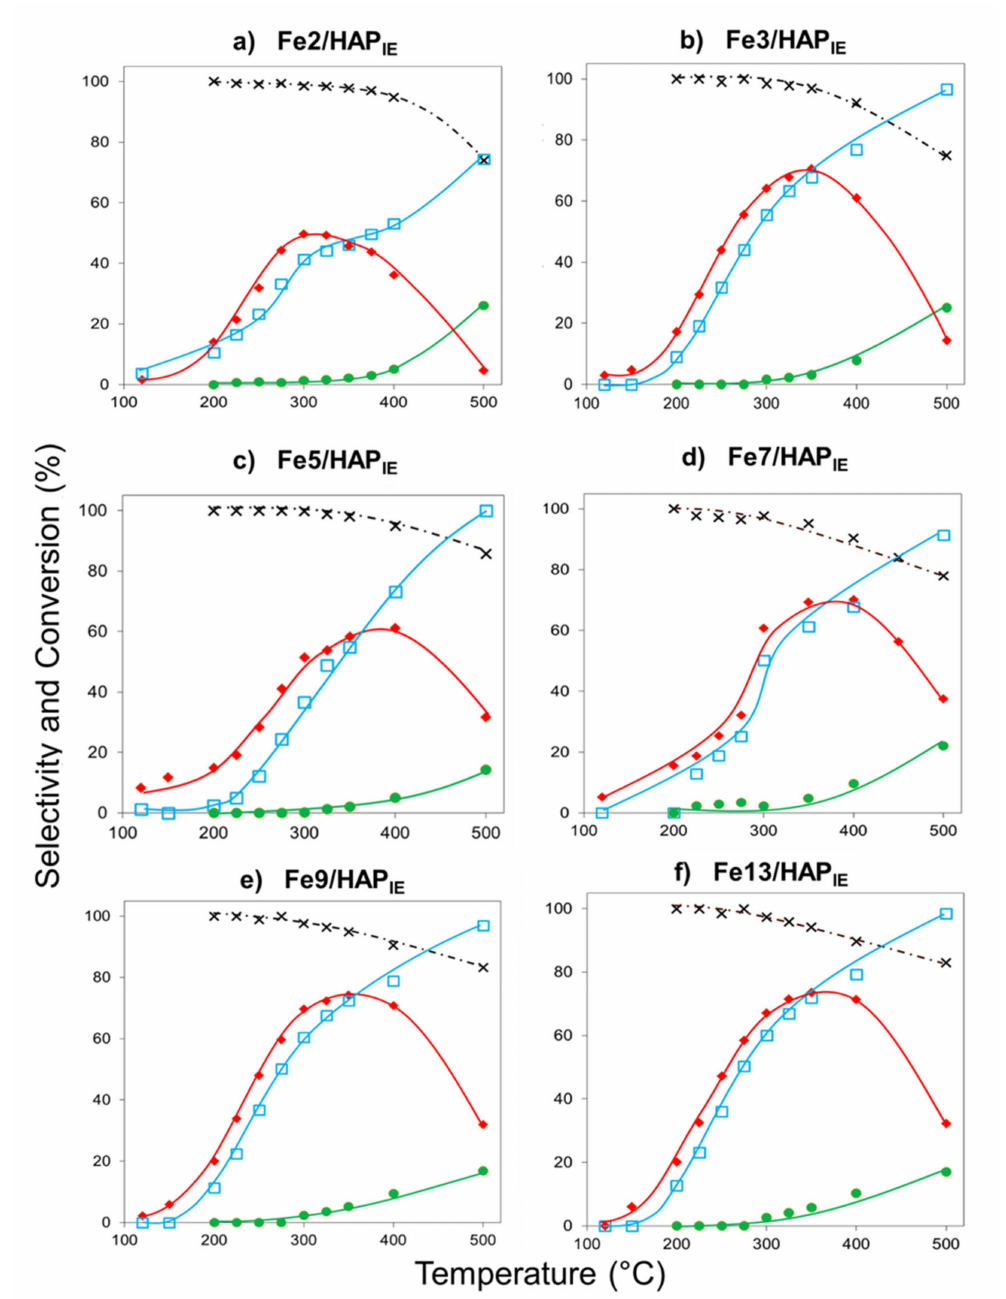
Figure 2. NH 3 -SCR catalytic activity results on Fe / HAP samples ( a – f ): profiles of conversion of the fed species (NH 3 , light blue and NO, red) and of selectivity of formed species (N 2 , black and N 2 O, green) as a function of temperature. Reaction conditions: [NH 3 ] = [NO] = 500 ppm, [O 2 ] = 10,000 ppm; GHSV = 30,000 h − 1